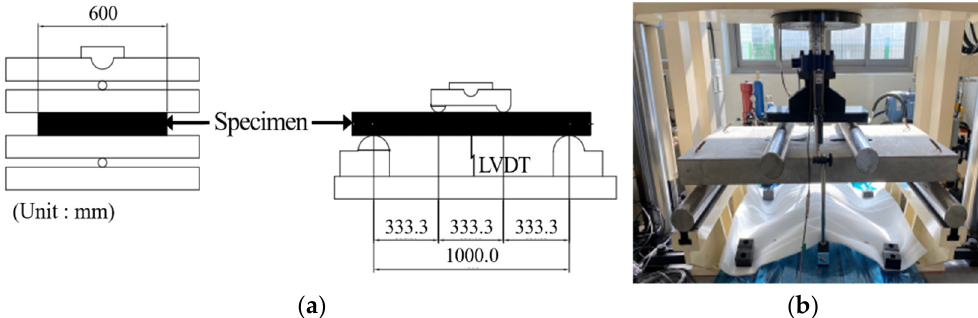
Figure 3. Flexural strength test. ( a ) Details of flexural strength test. ( b ) Setup for flexural test.